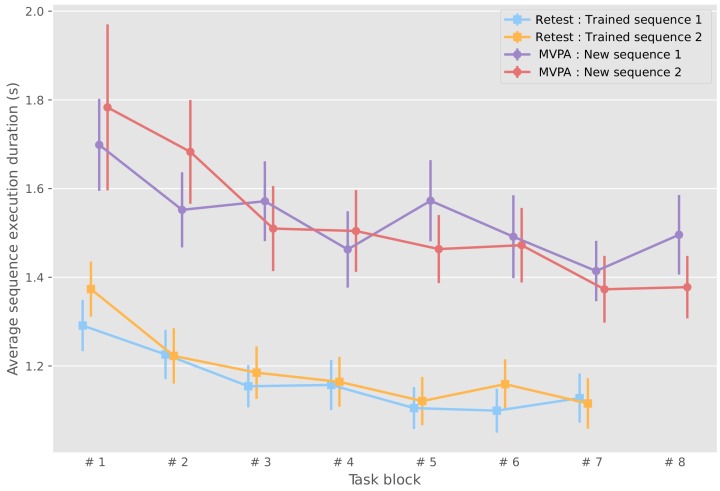
Sequence duration of trained sequences in the first blocks for each sequence on the last experimental day (mean and standard error across participants).